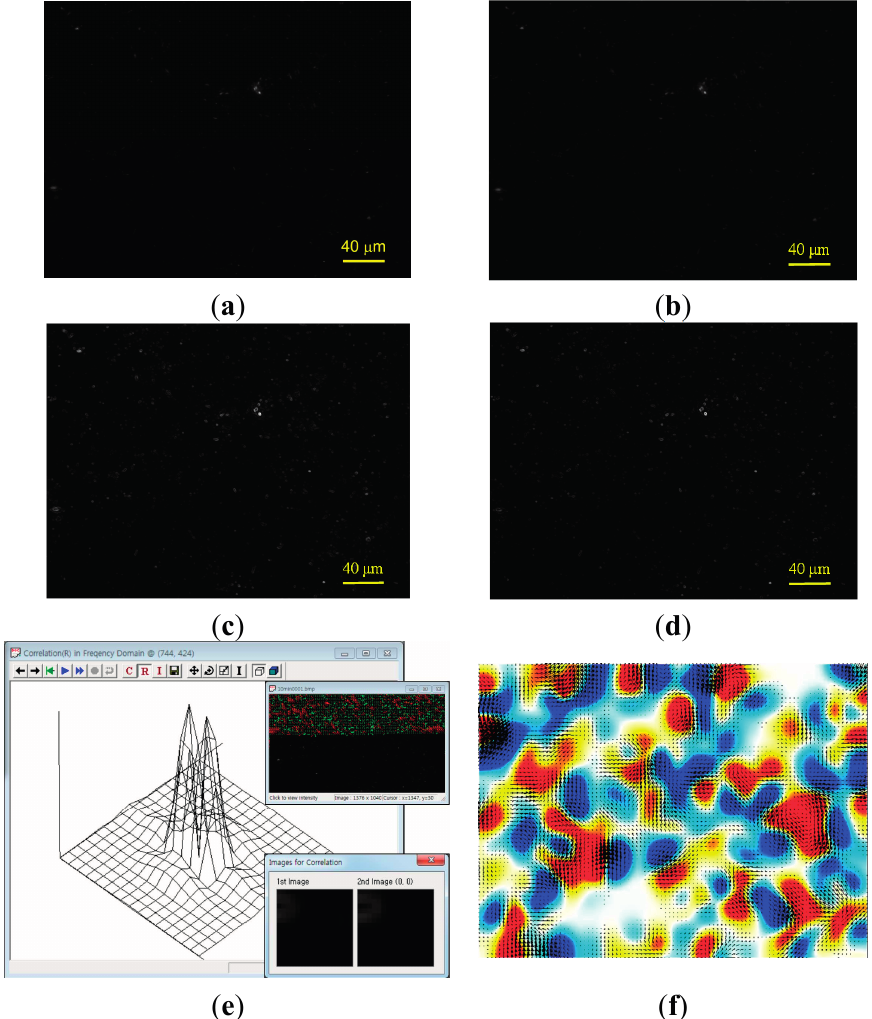
Figure 6. Swarm sample images of fluorescent beads undergone specific steps for image processing and analysis. ( a ) Raw image of swarm colony; ( b ) Smooth; ( c ) Find edge; ( d ) Subtract background (rolling = 10); ( e ) Particle image velocimetry analysis based on cross-correlation method; and ( f ) Velocity vector and vorticity